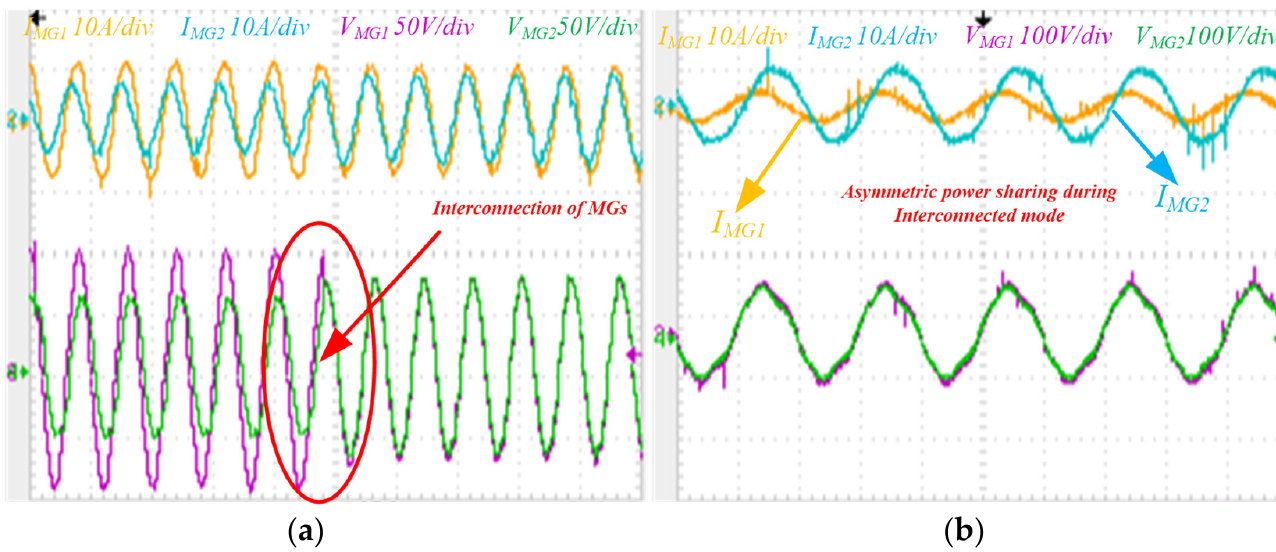
Figure 13. Illustration of CMGs power-sharing—( a ) symmetric and ( b ) asymmetric power-sharing.